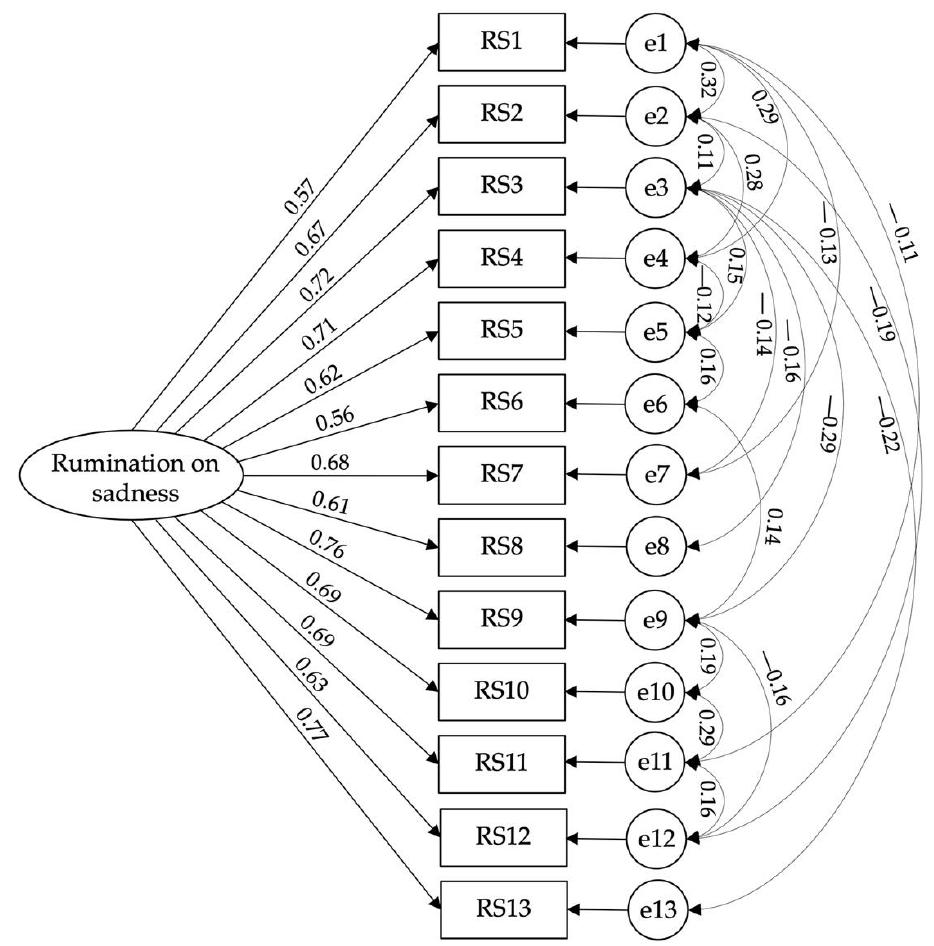
Figure 1. Model fit of Rumination on Sadness Scale. Confirmatory factorial analysis of the self-hatred scale [ χ 2 (11) = 5.118; CFI = 0.992; TLI = 0.984; IFI = 0.992; RMSEA = 0.064; PCLOSE = 0.069: SMRM = 0.015] (Figure 2), hostil- ity scale [ χ 2 (2) = 4.216; CFI = 0.995; TLI = 0.976; IFI = 0.995; RMSEA = 0.057; PCLOSE = 0.317: SMRM = 0.012] (Figure 3), psychological vulnerability scale [ χ 2 (7) = 2.886; CFI = 0.992; TLI = 0.983; IFI = 0.992; RMSEA = 0.044; PCLOSE = 0.644; SMRM = 0.018] (Figure 4), and tourism wellbeing scale [ χ 2 (16) = 3.787; CFI = 0.979; TLI = 0.964; IFI = 0.980; RMSEA = 0.053; PCLOSE = 0.339: SMRM = 0.029] (Figure 5) were carried out to assess the models’ adjust- ments. Despite finding good fits for all models, some correlations between errors were established to achieve such fits. Thus, hypothesis H3 is